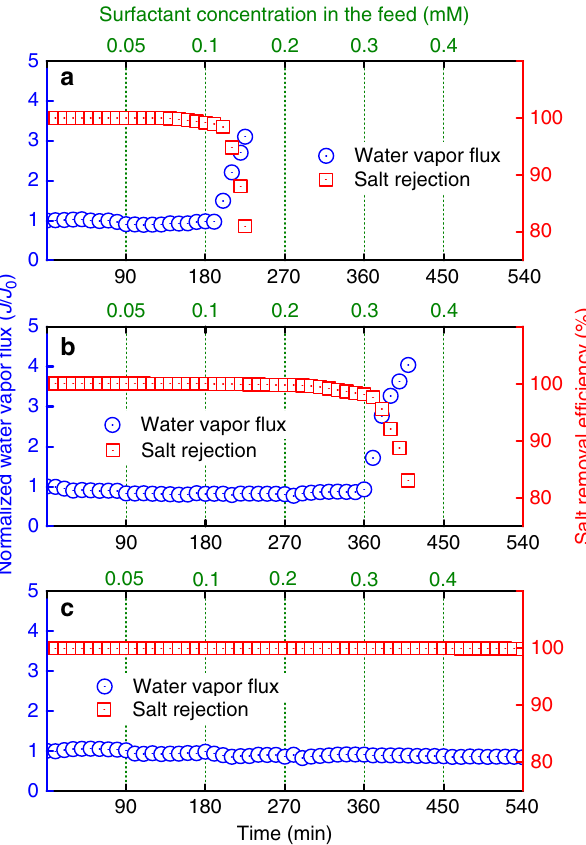
Fig. 2 Membrane distillation (MD) performance of different PVDF membranes. Normalized water vapor fl ux (blue) and salt rejection (red) of a pristine PVDF membrane, b PVDF-FAS-5 membrane, and c PVDF-FAS-60 membrane in direct contact membrane distillation (DCMD) desalination, based on sequentially increasing doses of SDS. The feed solution contained 1 M NaCl, supplemented with various concentrations of SDS. The feed and distillate temperatures were maintained at 60 °C and 20 °C, respectively. Replicate results under identical experimental conditions are presented